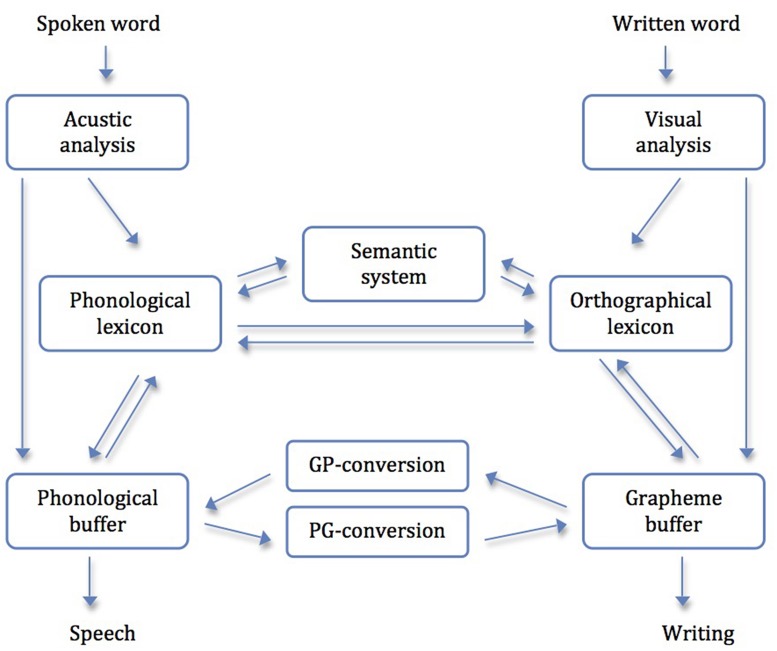
The dual route model of reading and writing (cf. Winkes, 2014).